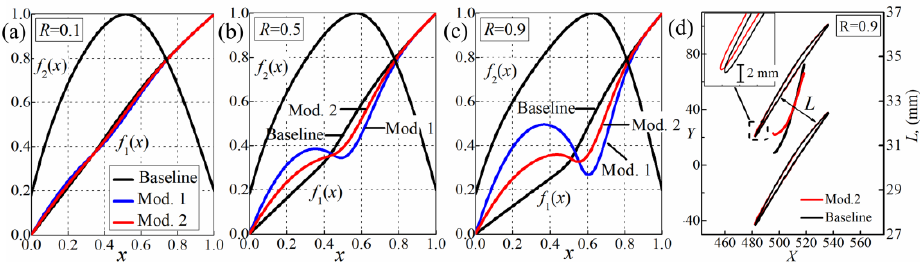
Figure 6. The normalized camber angle distribution f 1 ( x ) of baseline, Mod.1 and Mod.2 ( a – c ); blade airfoil and passage width distribution comparison at R = 0.9 ( d ).